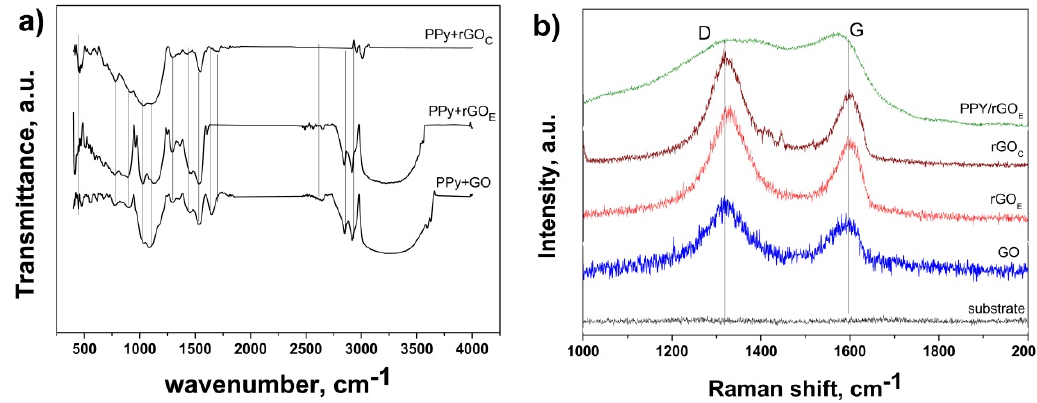
Figure 3. FTIR ( a ) and Raman ( b ) spectra of the coatings at the surface of the NiMoP coated ceramic.